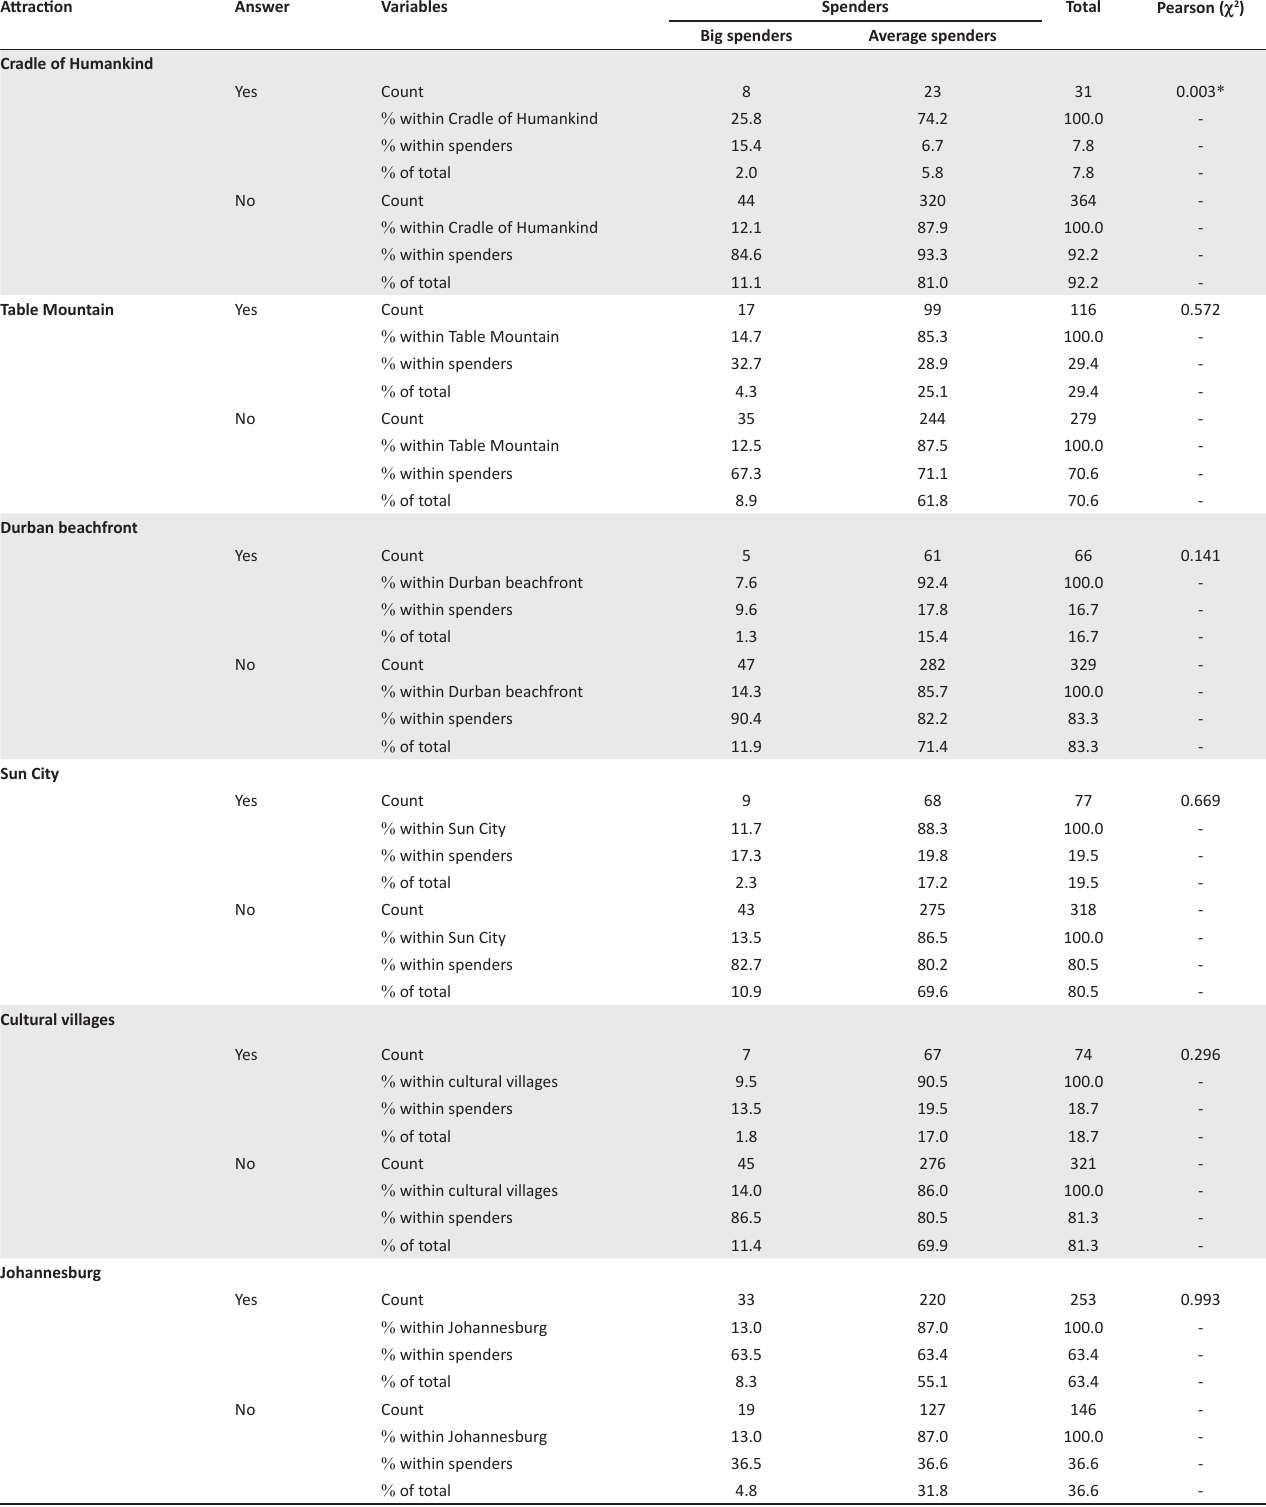
TABLE 7 (Continues...): Cross-tabulation of spending